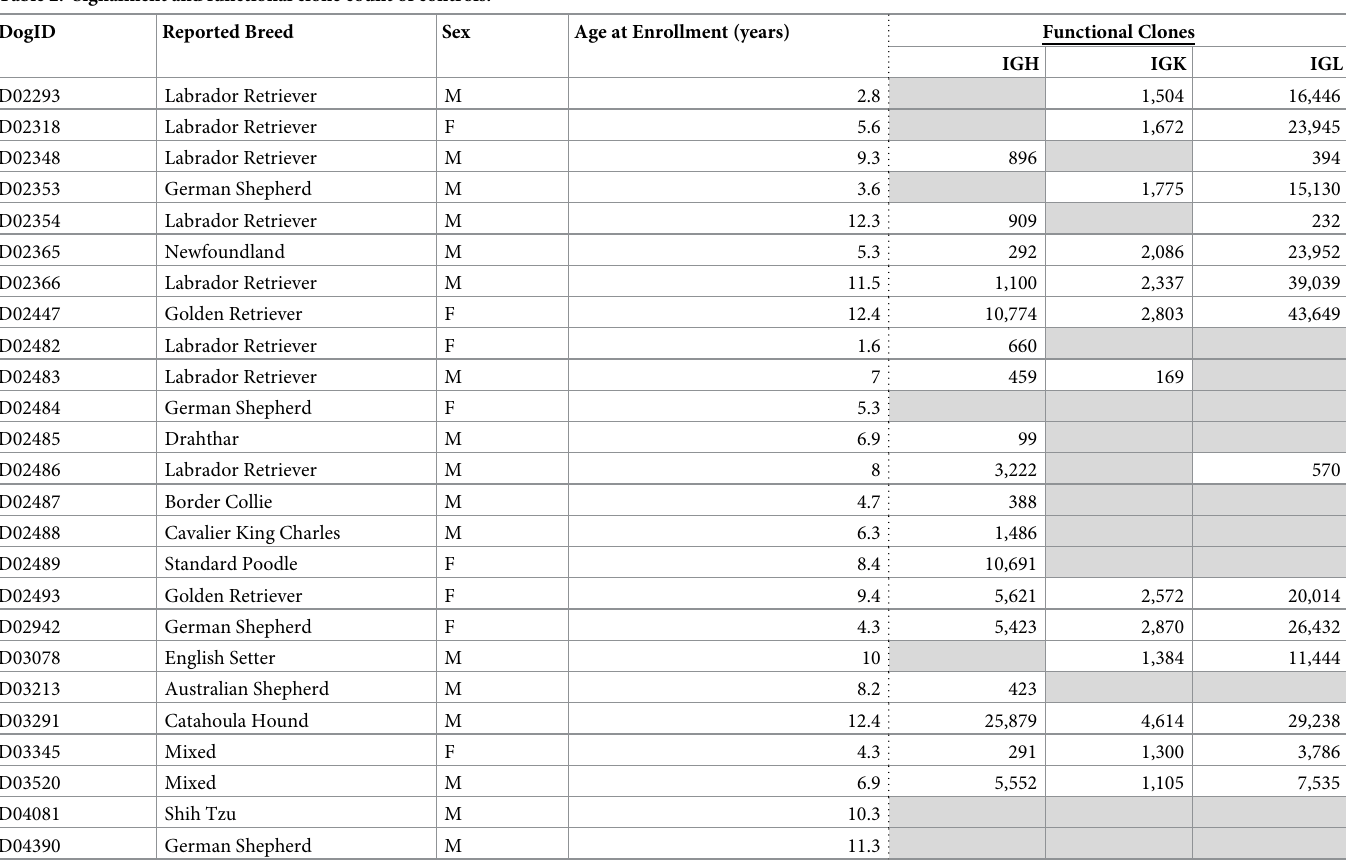
Table 2. Signalment and functional clone count of